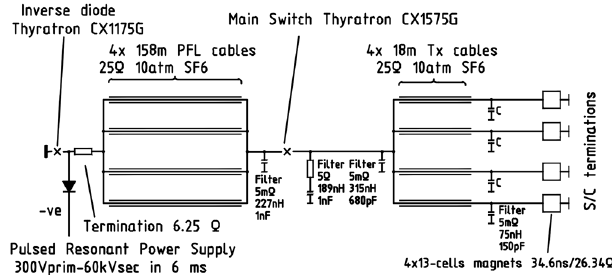
FIG. 15. Simplified electrical schematic of the PSB extraction kicker system for one of the four rings.